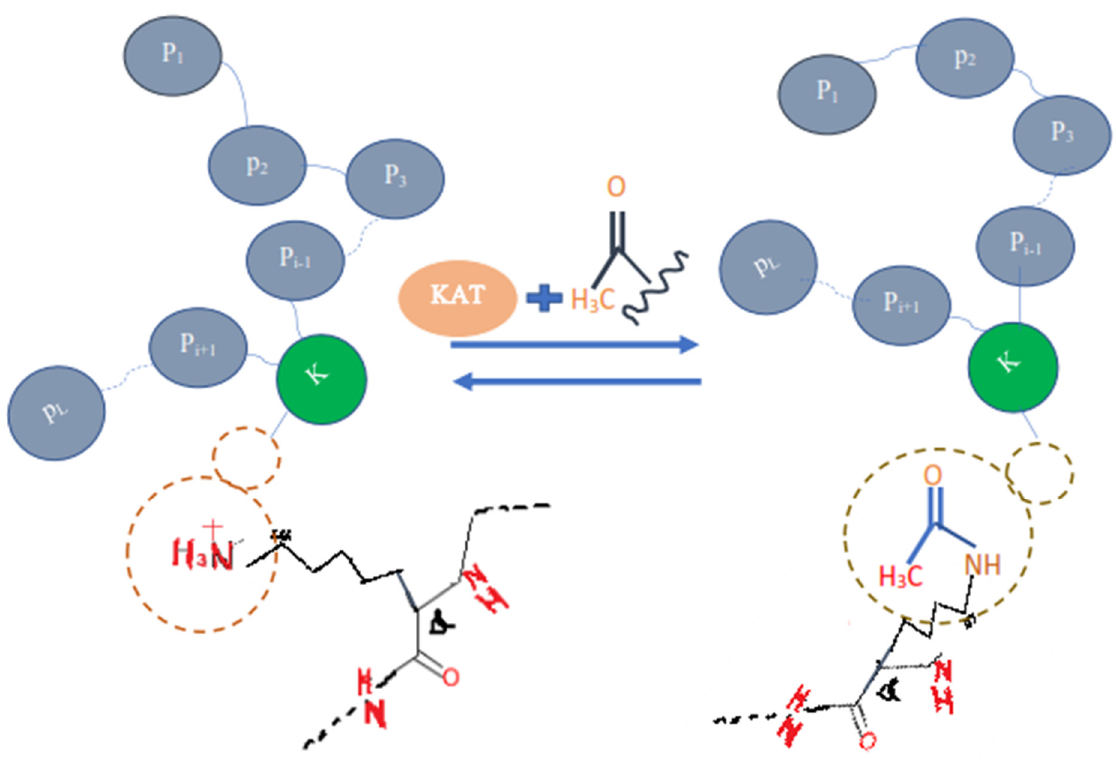
Figure 1. Acetylation